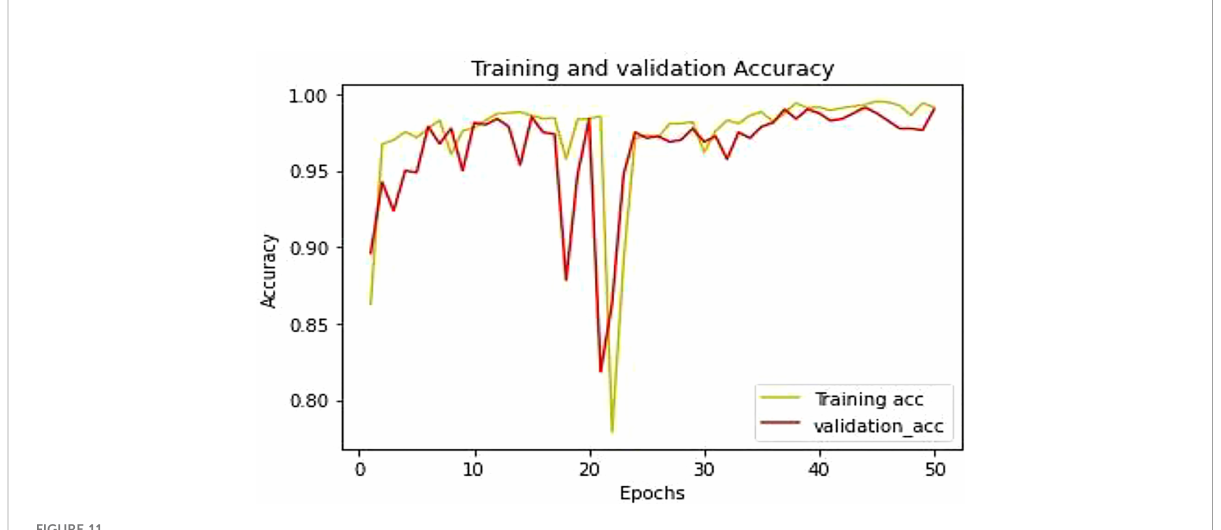
FIGURE 11 Training and validation models